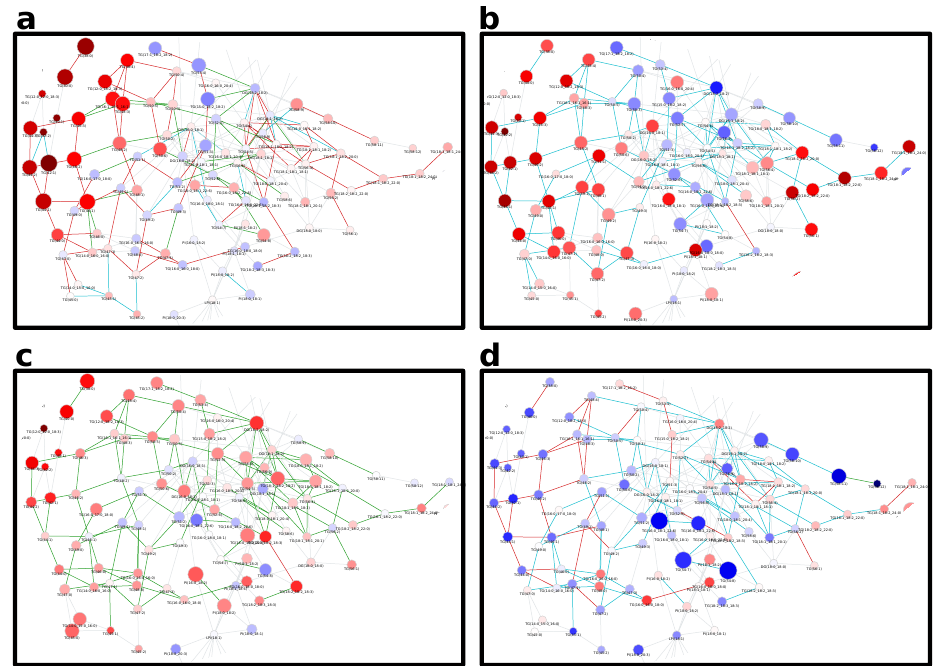
Figure A7. Neutral lipid subnetwork based on Kyle et al. [22] comparing ( a ) Toddler to